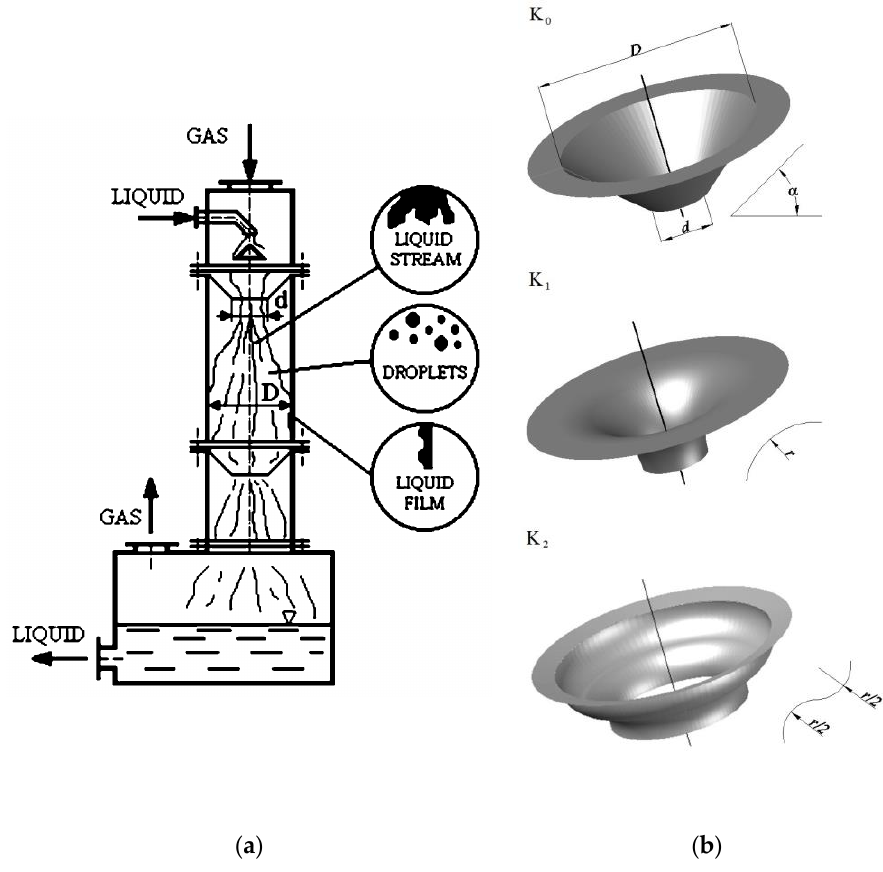
Figure 1. Scheme of the spray cascade cocurrent absorber: ( a ) Confusor constructions studied; ( b ) K 0 — classical, K 1 — with profiled inside surface, K 2 — with double profiled inside surface.